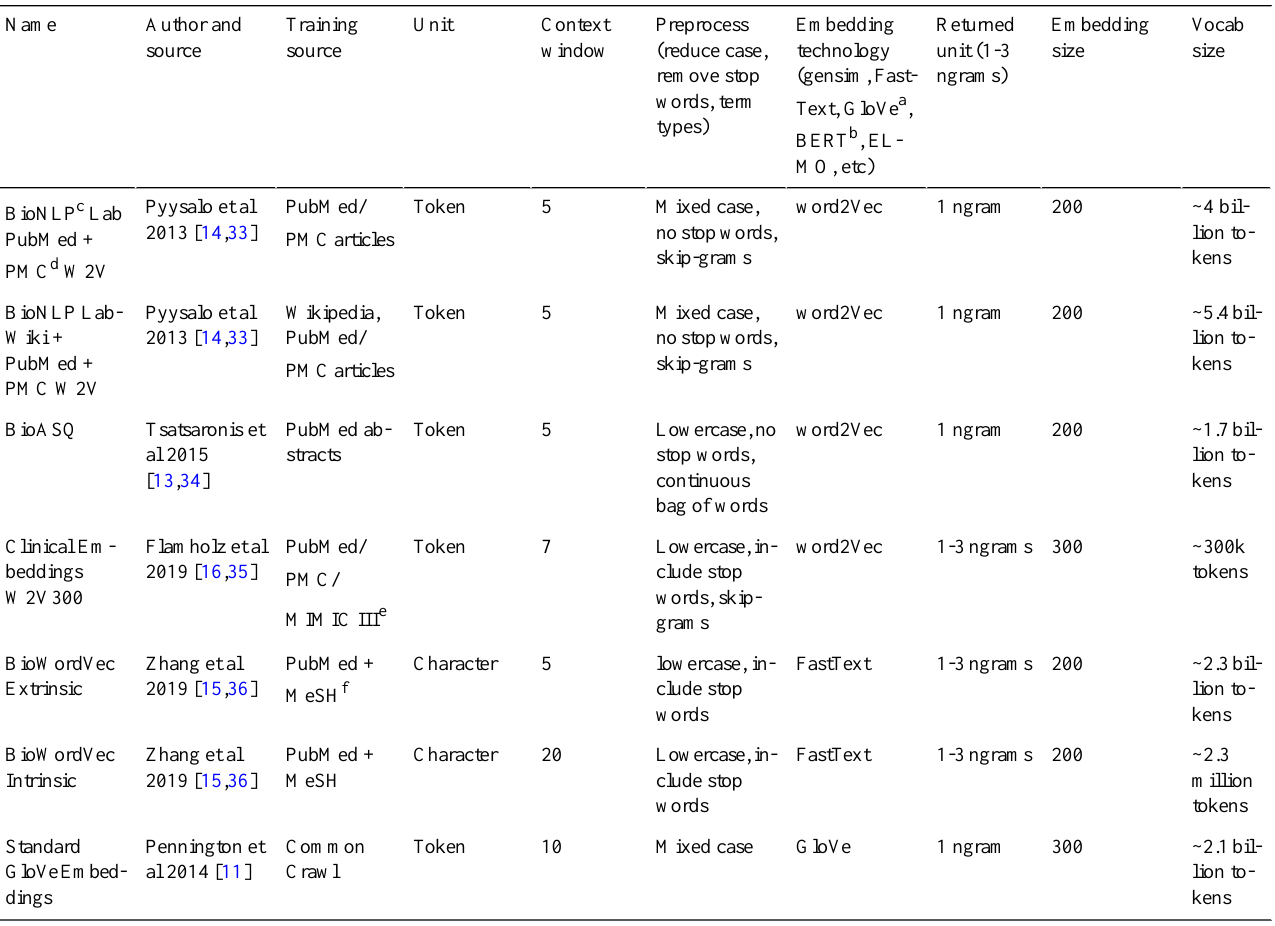
Table 1. Description of word embedding sources